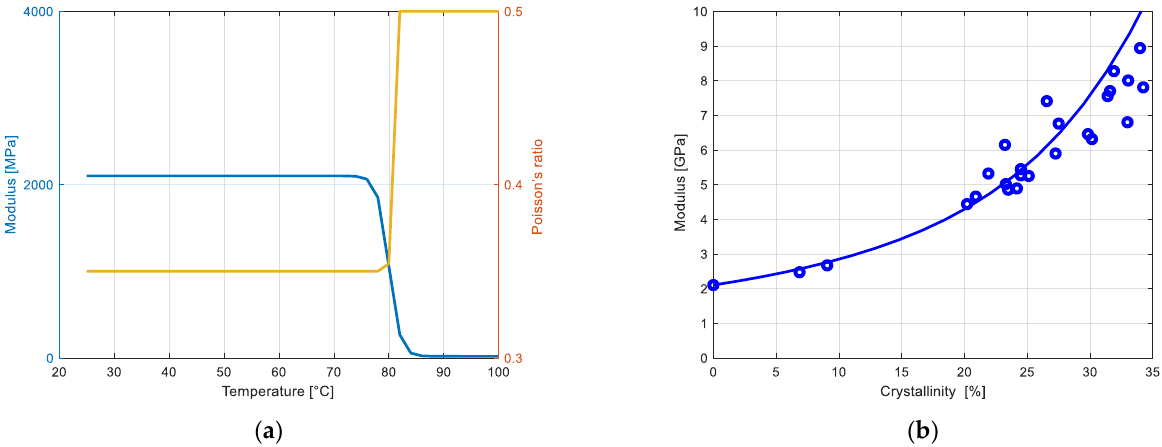
Figure 2. Model results of the linear elastic response: ( a ) amorphous elastic constants as a function of temperature, ( b ) overall modulus as a function of crystal content; solid lines: model; symbols: experimental data of Cosson et al. [11].